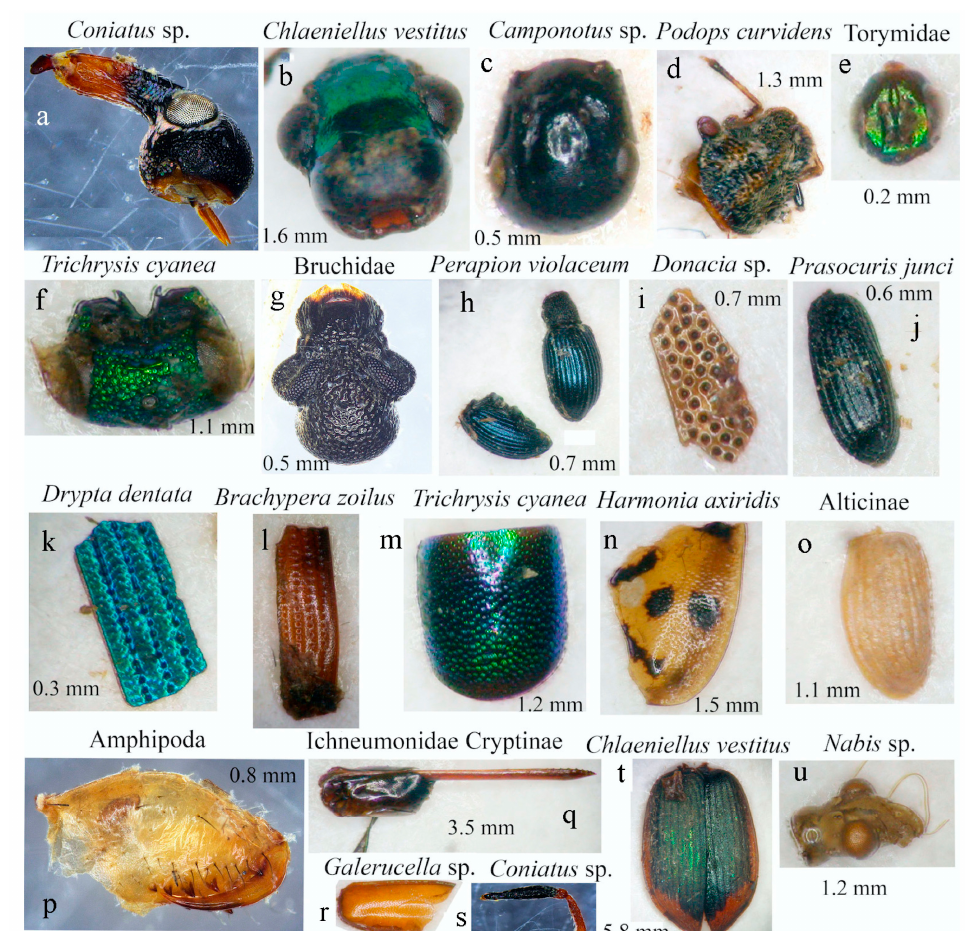
Figure 2. Prey found in the fecal samples of the Reed Warbler and their size: ( a ) Coniatus sp. (Curculionoidea, head); ( b ) Chlaeniellus vestitus (Carabidae, head); ( c ) Camponotus sp. (Formicidae,